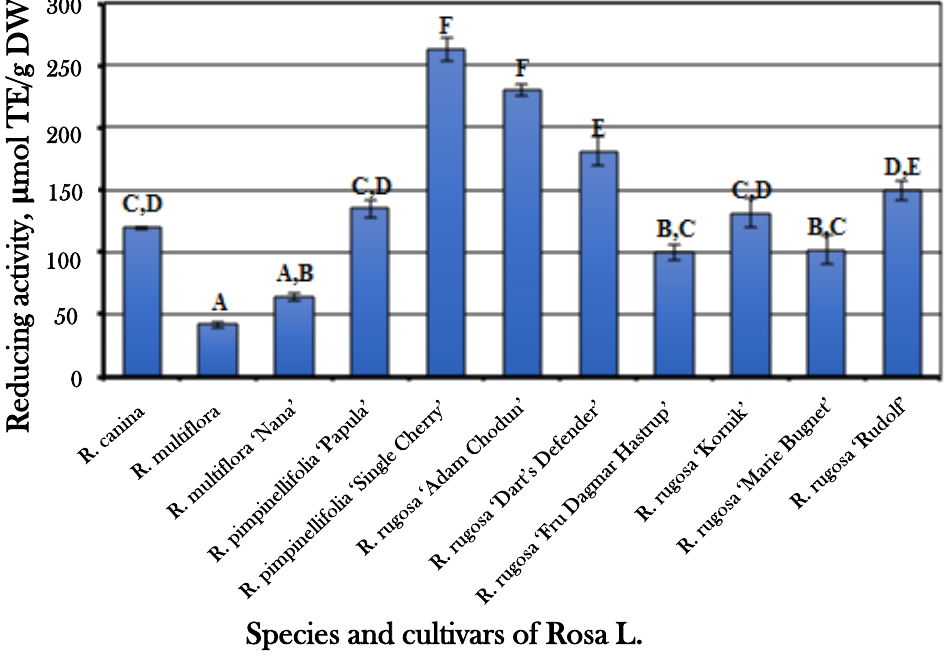
Figure 8. Variability of the reducing activity of Rosa L. fruit-sample extracts in vitro; different let- ters indicate statistically significant ( p < 0.05) differences between the samples .